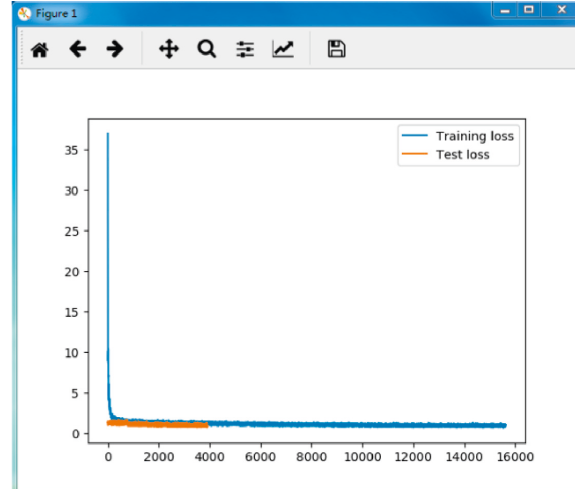
Figure 5: Training loss and test loss with different parameter